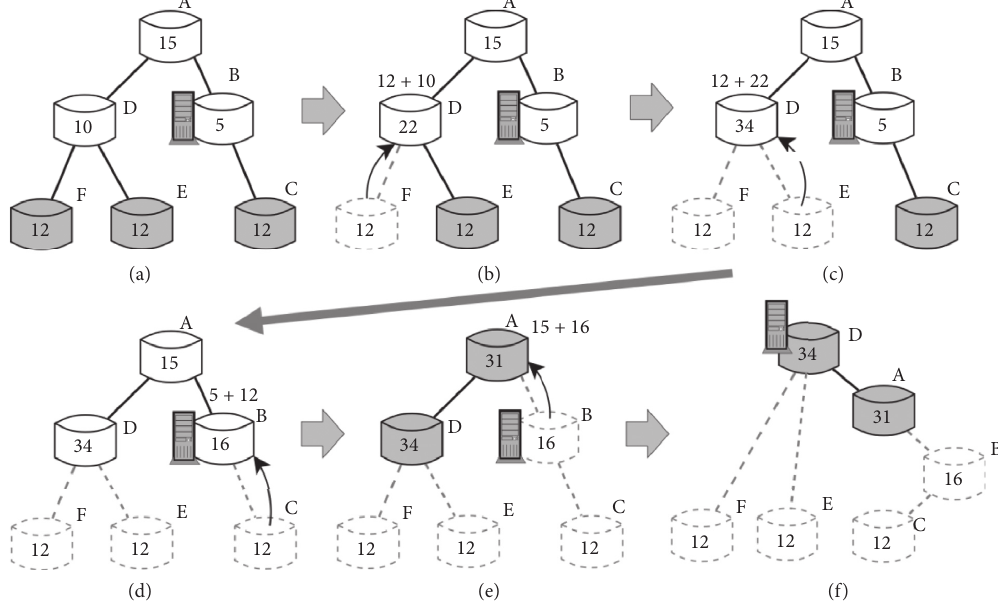
Figure 3: Solution to the equal traffic weight problem in the leaves nodes in